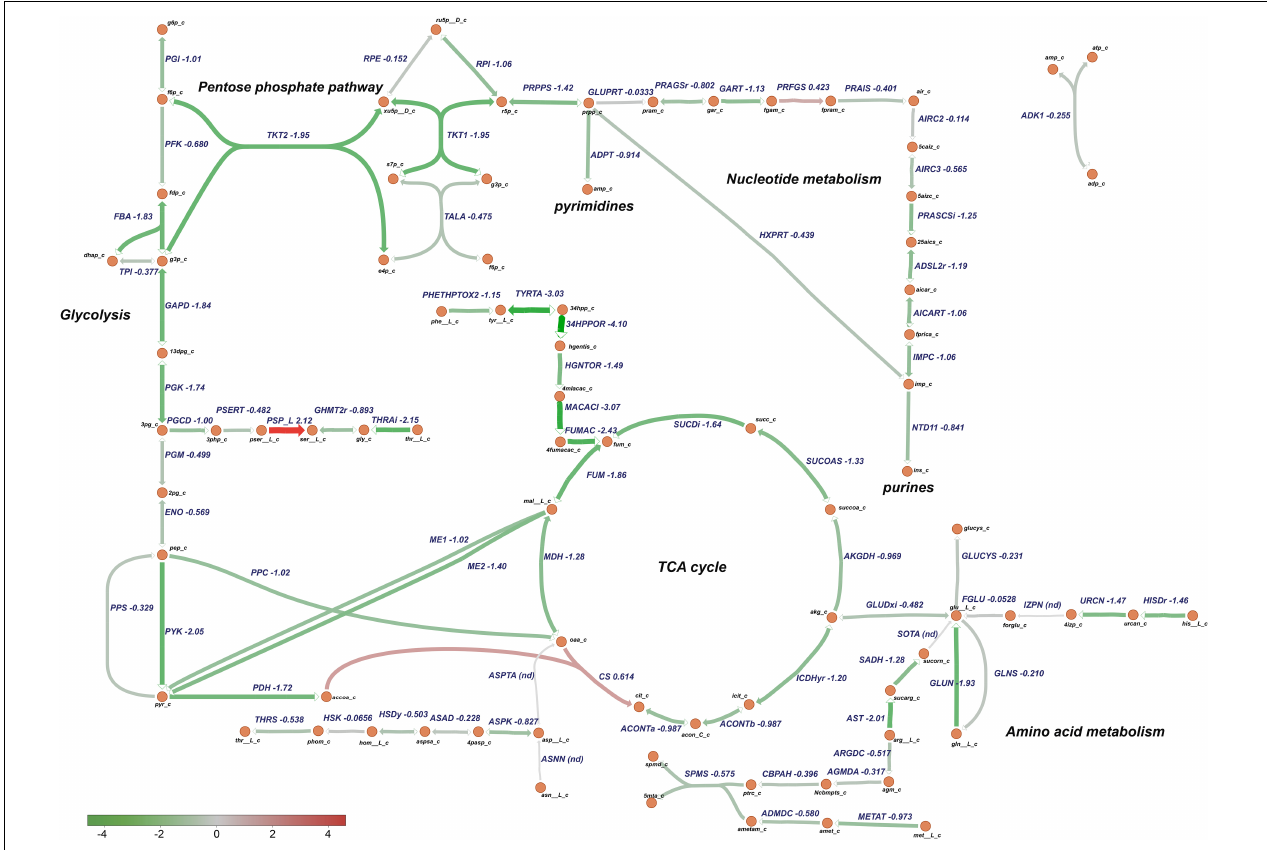
FIGURE 10 | Downregulation of central metabolic pathways in P. salmonis in CMMAB medium. Genes differentially expressed between P. salmonis grown in the CMMAB medium without amp and the Austral-SRS medium were mapped to the TCA cycle, pentose phosphate pathway, nucleotide, and amino acid metabolism using the genome-scale model iPS584. Expression levels are shown as log 2 fold-change values; downregulated genes are in green and upregulated genes are in